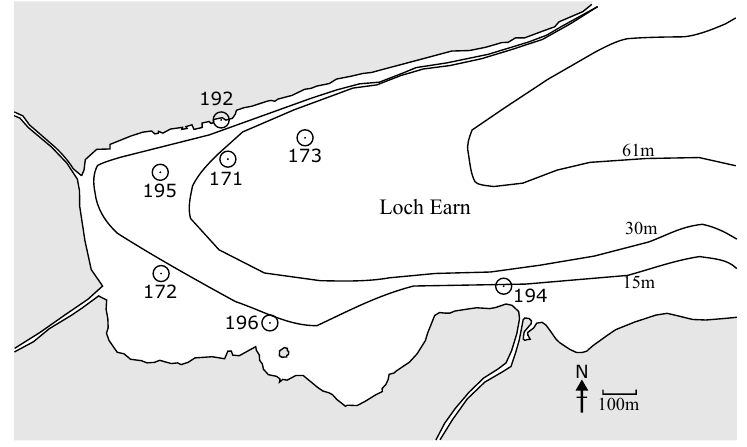
Figure 22. Map of nodes with addresses in Loch Earn. One gateway node (192) positioned at the wharf. Six sensor nodes distributed in the loch.